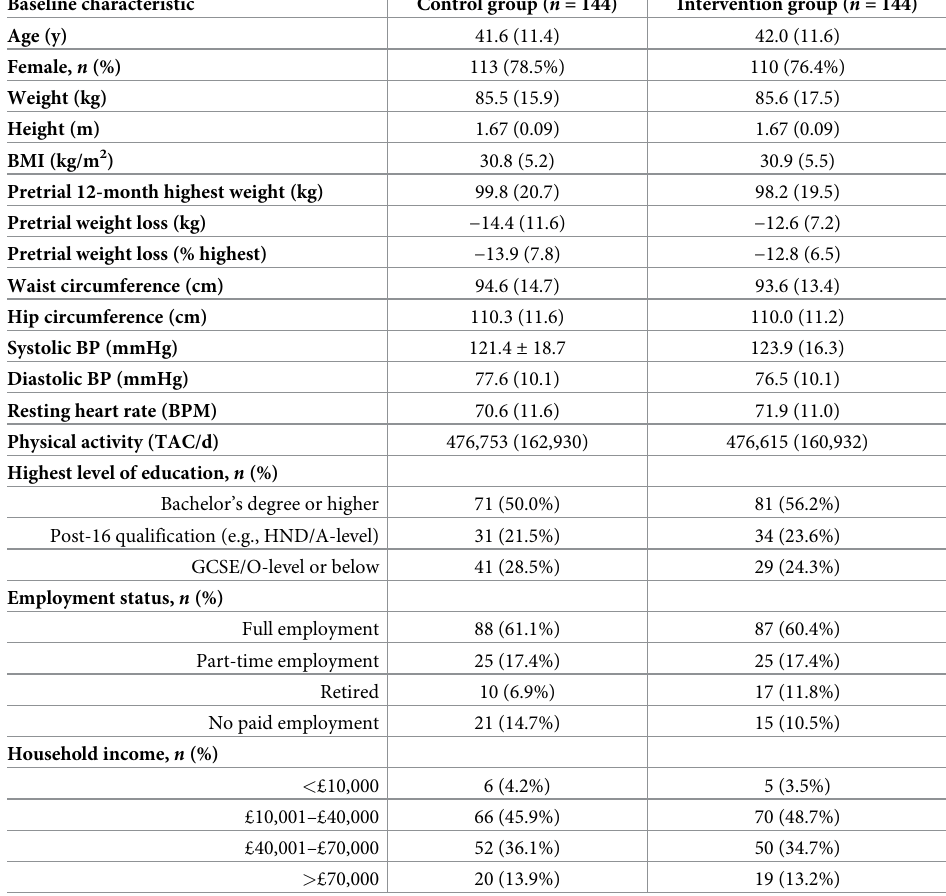
Table 1. Baseline characteristics of all individuals included in the NULevel trial. Baseline